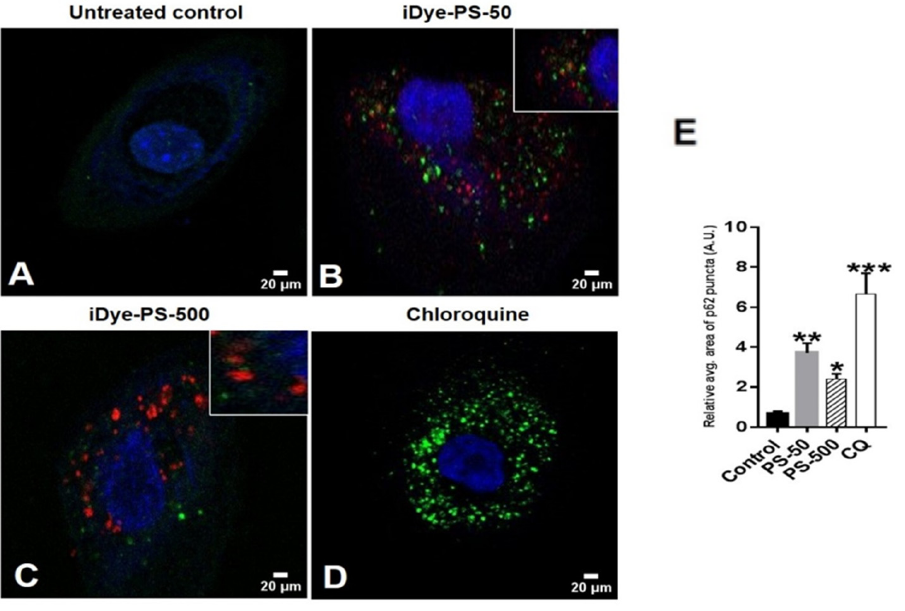
Figure 8. The confocal images represent the expression of p62 (green) after exposure of HNEpCs to 100 µ g/mL of iDyePS-50 (red) and iDyePS-500 (red) for 24 h. ( A ) Untreated control. ( B ) Observation of iDyePS-50 (red) and p62 (green) puncta together in cytoplasmic regions or colocalization of iDyePS-50 and p62 (yellow, depicted in inset). ( C ) Presence of iDyePS-500 (red) and p62 (green) together in cytoplasmic regions or colocalization of iDyePS-500 and p62 (yellow, depicted in inset). ( D ) chloroquine as a positive control for p62 (green). ( E ) The histogram depicts the measurement of the relative average area of fluorescence (green/p62 puncta, AU) due to iDyePS-50 and iDyePS-500 over the untreated control. * p ≤ 0.05, ** p ≤ 0.01, *** p ≤ 0.001 vs. untreated